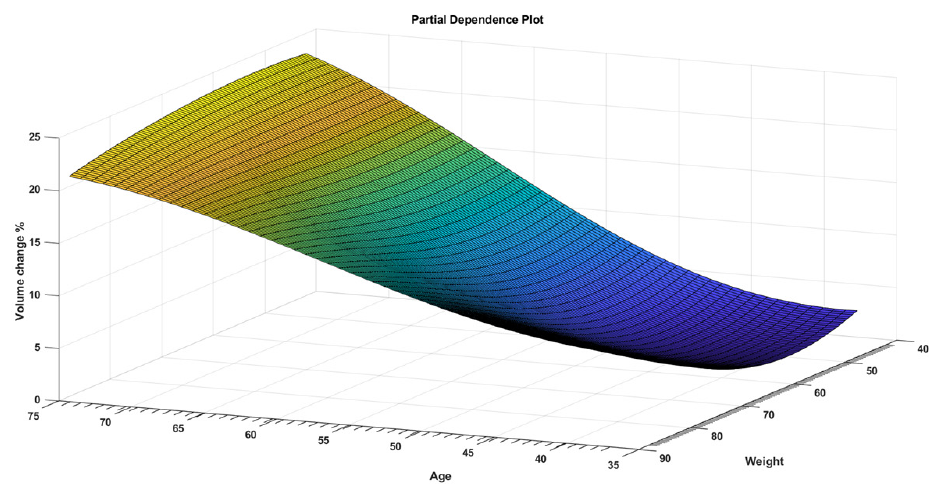
Figure 4. A PDP that visualizes partial dependence of predicted responses (volume change %) on the predictor variables weight and age.